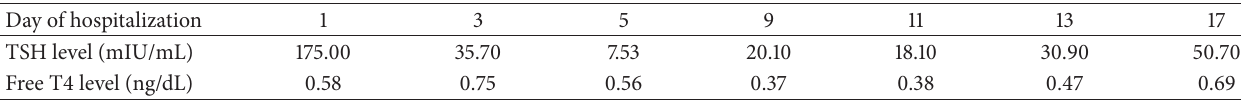
Table 1: Measured TSH and free thyroxine (T4) levels during hospitalization. Normal values for TSH range between 0.358 and 3.74 mIU/mL and free T4 range between 0.76 and 1.46 ng/dL.